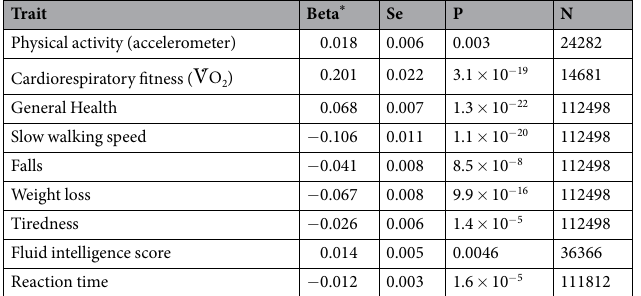
Table 1. Association between genetic risk score for grip strength and frailty indices. * Per SD in genetic risk score and outcome variable. Genetic risk score was calculated as a sum of grip strength increasing alleles, weighted with the effect sizes from discovery analysis. Associations with frailty indices were tested in the replication sample. V ̇ O 2 : net oxygen